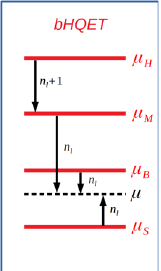
Figure 1: Running setup for bHQET considering only primary quark mass. μ H , μ M , μ B and μ S are the natural scales corresponding to the matrix elements H , H M , B τ and S τ respectively. μ is the final common scale and n l is the number of massless flavours. Next to each arrow is indicated the number of active flavours in that patch.